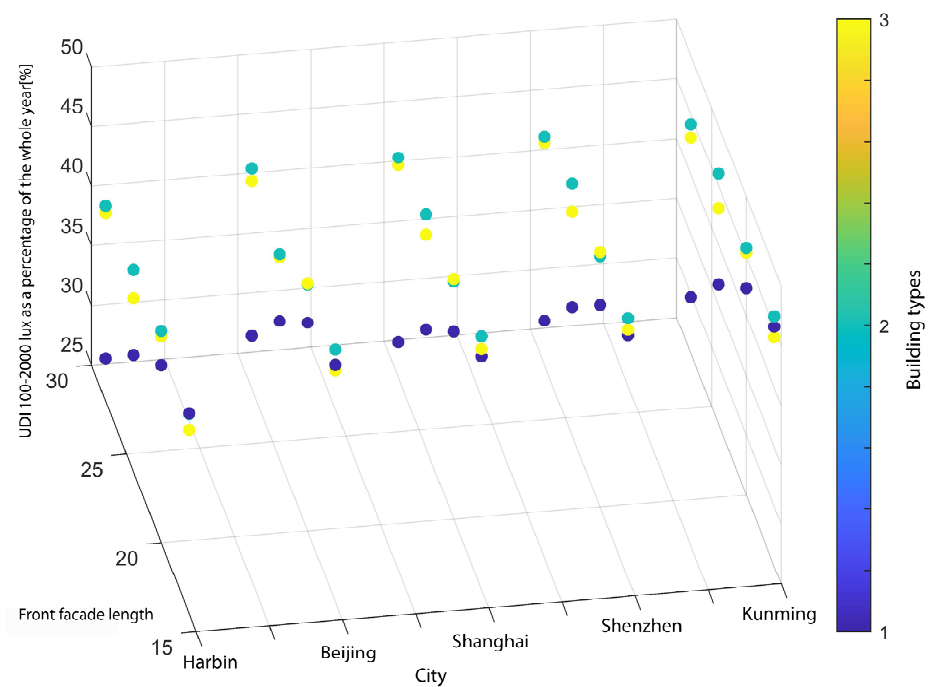
Figure 24. Relationship between the length of the front elevation and the effective lighting illuminance of the whole